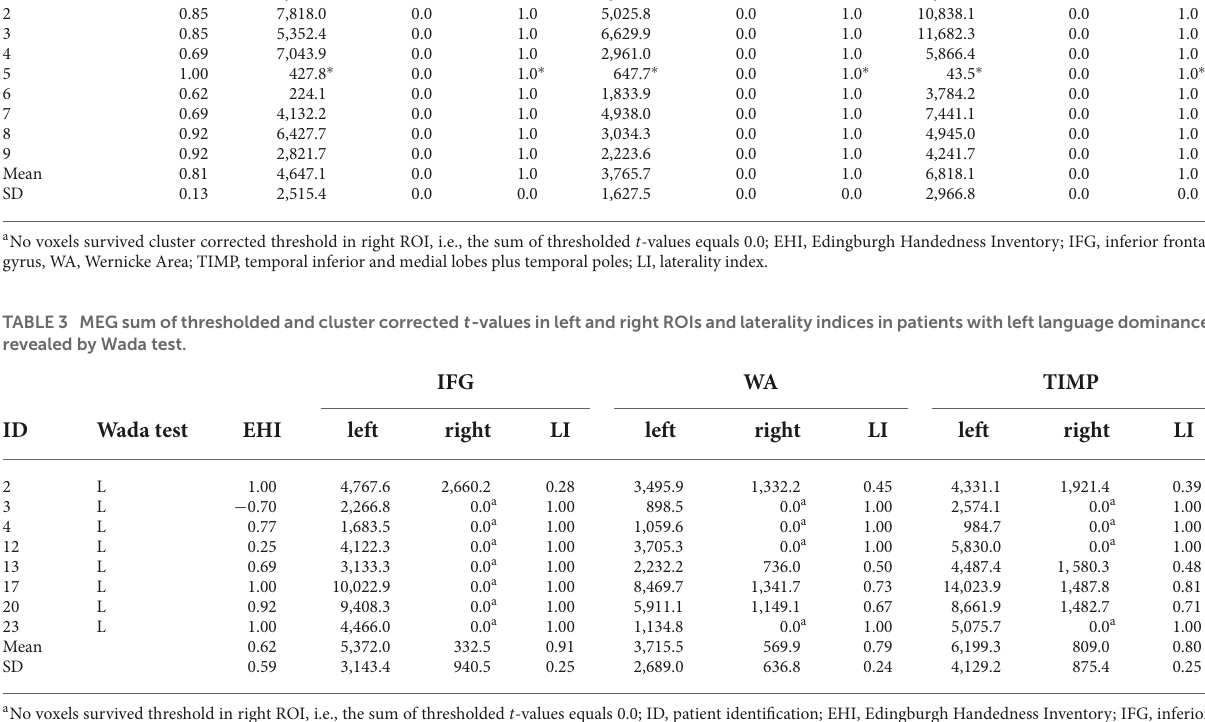
TABLE 2 MEG sum of thresholded and cluster corrected t -values ( p < 0.05, cluster-corrected and “ ∗ ” = uncorrected) in left and right ROIs and laterality indices in healthy controls. Broca Wernicke TIMP Control no EHI left right a LI left right a LI left right a